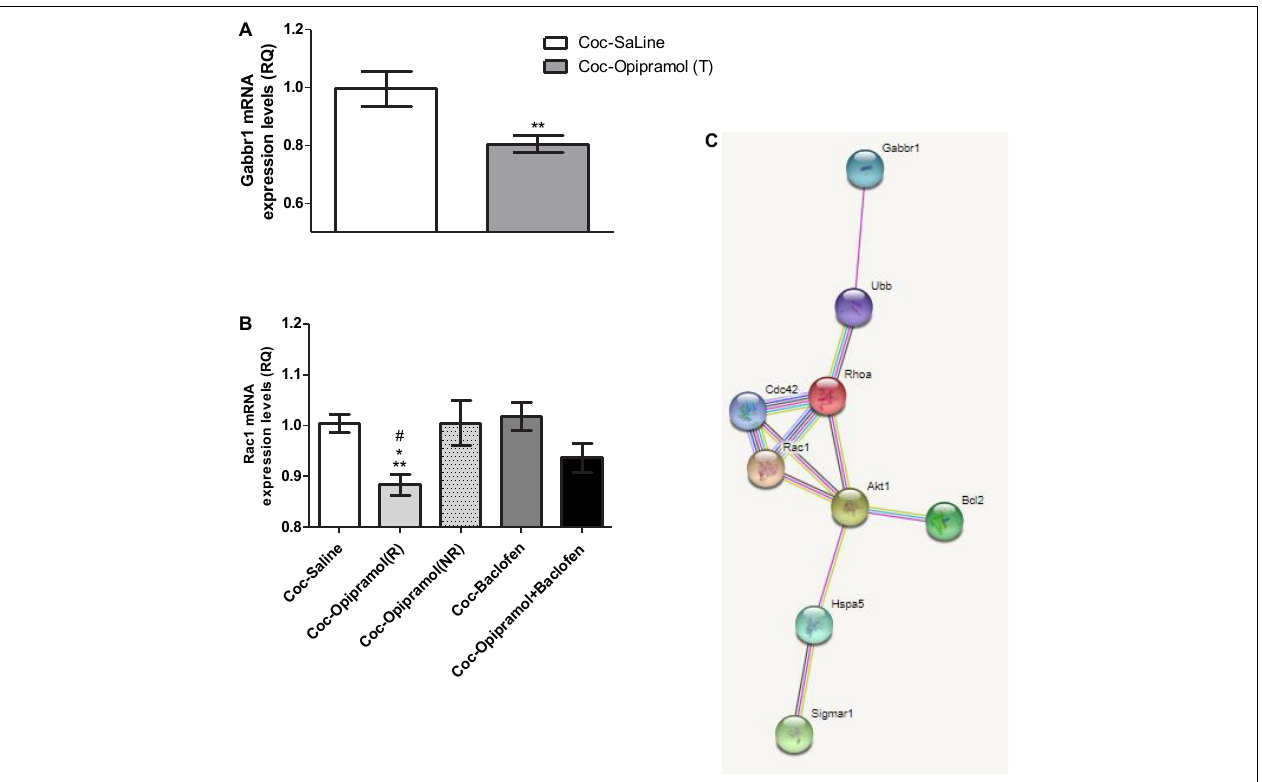
FIGURE 4 | Effects of the various drug-combinations on Gabbr1 and Rac1 mRNA expression levels in the nucleus accumbens (NAc). (A) A Student’s t -test revealed a significant effect of opipramol treatment alone on the expression of Gabbr1 (** p = 0.0063). (B) Newman-Keuls post hoc test revealed a significant decrease in Rac1 mRNA expression levels in the opipramol responders (R) [Coc-Opipramol (R)] compared with the non-responder (NR) rats [Coc-Opipramol (NR)], as well as compared to high dose baclofen (3.2 mg/kg) alone treated rats (Coc-Baclofen), and compared to controls (Coc-Saine) (one-way ANOVA, * p < 0.05, # p < 0.05, and ** p < 0.01, respectively). Values are expressed as mean ± SEM. (C) STRING software (version 11.0) revealed a complex of interacting proteins including Gabbr1, Rac1, and σ -1 receptor in a PPI enrichment analysis, p = 0.0272. The software indicates that the examined proteins are at least partially biologically connected.